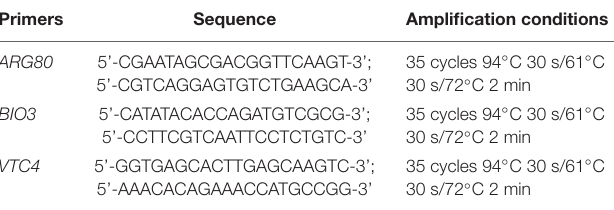
TABLE 2 | List of QPCR primer pairs designed and used for this study. Primers Sequence